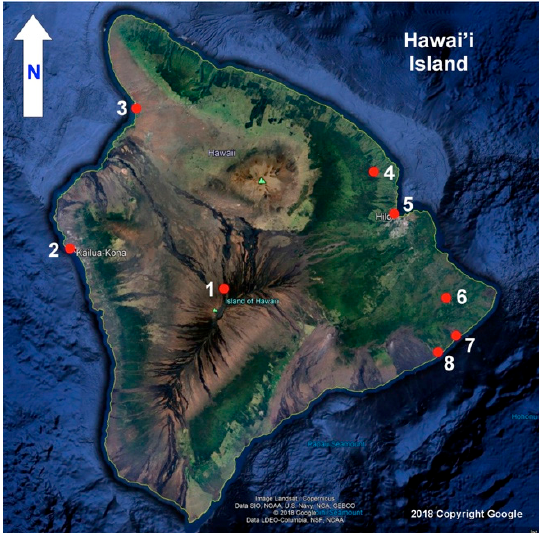
Figure 1. Principal ultraviolet radiation (UVR) study sites are indicated by numbered red dots on this satellite image of Hawai’i Island (unannotated image copyright by Google 2018). 1. Mauna Loa Observatory. 2. Old Kona Airport Park. 3. Spencer Beach. 4. Akaka Falls. 5. Hilo waterfront. 6. P ā hoa.